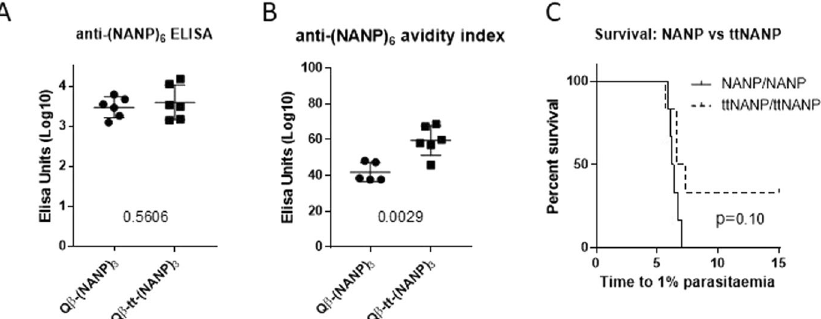
Fig. 6 Effects on immunogenicity and protective ef fi cacy of tetanus toxin CD4 + T-cell epitope fusion with Q β -(NANP) 3 . Q β VLPs were chemically coupled with tetanus toxin P2 epitope fused to (NANP) 3 (Q β -tt-(NANP) 3 ) or just to (NANP) 3 (Q β -(NANP) 3 ) and used to vaccinate BALB/c mice ( n = 6 per group) by intramuscular injection, using 1 µg per dose, two shots, a 3 week prime-boost interval, with Matrix-M ™ adjuvant. A Serum was collected from mice 2 weeks post-boost and standard curve ELISAs performed against (NANP) 6 . B The avidity index was calculated by taking the ratio of anti-(NANP) 6 titres with and without treatment of sera with 7 M urea. Numbers on graphs represent p values from t tests between groups. C Mice were challenged intravenously with 1000 PfCSP transgenic P. berghei sporozoites 3 weeks post- boost. Daily thin blood smears were used to determine the time to reach 1% blood-stage parasitaemia by linear regression. p Value from log- rank test. Means are shown ±